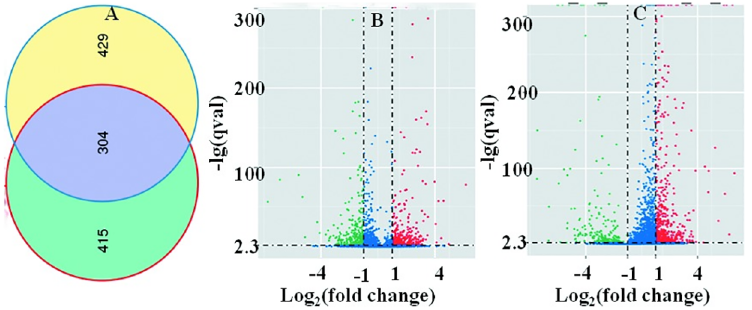
Fig 2. The DEGs of Natrinema sp. J7-2 cells in media of different salinities. A, Venn diagram for the comparisons of the DEGs of cells; the red circle represents the DEGs in 15% vs 25% NaCl and the blue circles in 25% vs 30% NaCl. B and C are volcanoplots that describethe distribution of the DEGs in 15% vs 25% NaCl and 25% vs 30% NaCl; the red dots are up-regulated genes; the green dots are down-regulated genes; the blue dots indicate geneswith no